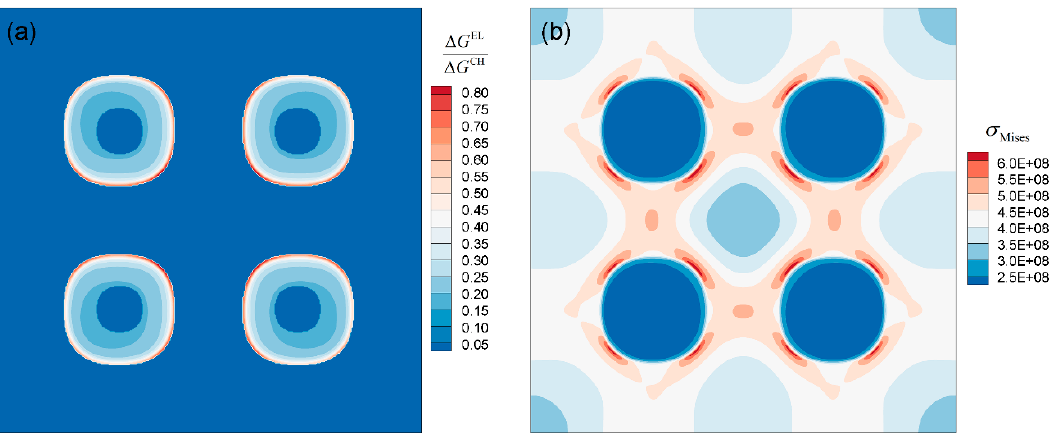
Figure 14. The ratio of elastic driving force to chemical driving force ∆ G EL / ∆ G CH ( a ) and von Mises stress distribution ( b ) of DD6 superalloy after 1120 ◦ C / 2 h.